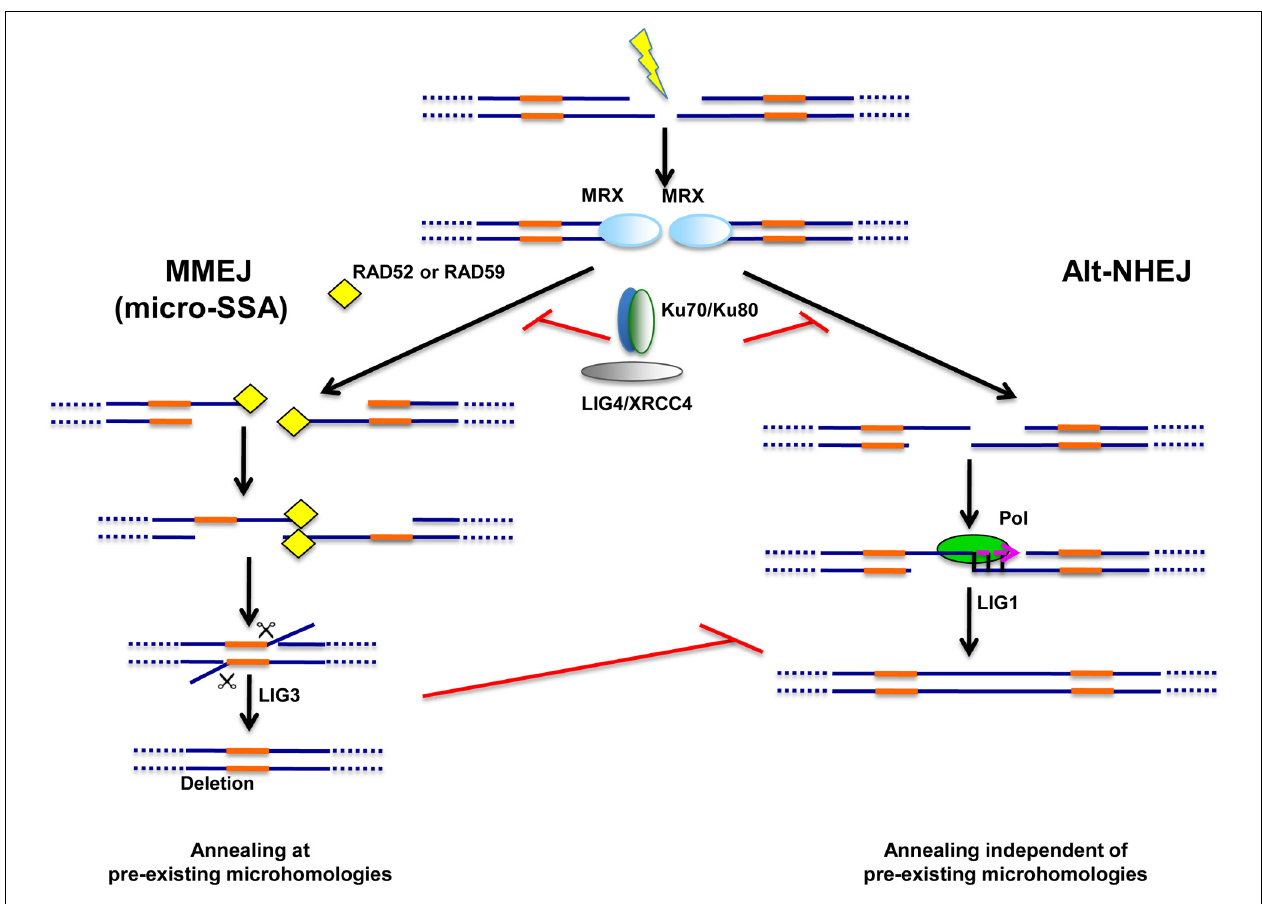
FIGURE 2 |Alternative end-joining pathways of DNA repair. Two types of alternative end-joining pathways of DSB repair were unraveled in NHEJ-deficient cells. One pathway, dubbed “microhomology-mediated end-joining” or MMEJ, relies on pre-existing microhomologies around the break (in orange) and is likely to operate through a mechanism related to single strand-annealing (micro-SSA). MMEJ appears to rely on Ligase III (LIG3) for sealing. Unlike MMEJ, the second alternative pathway, dubbed Alt-NHEJ, does not require the presence of pre-existing microhomologies